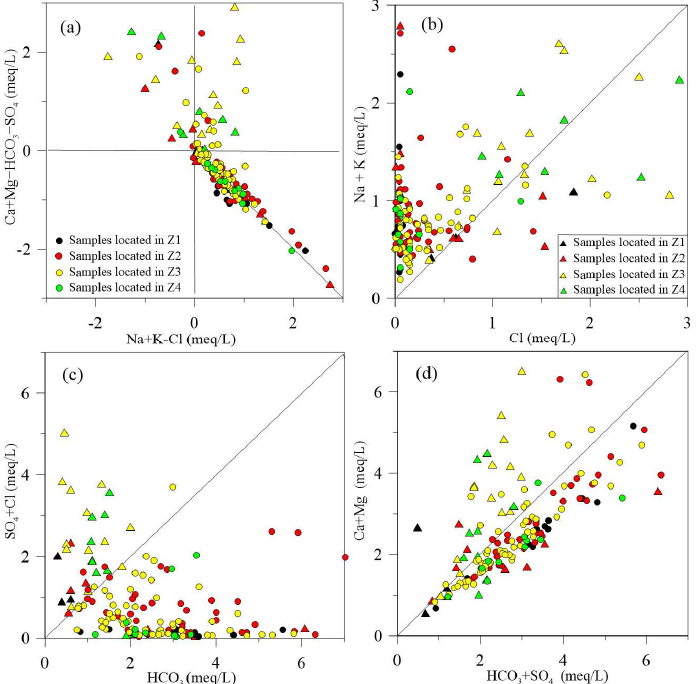
Figure 6. Bivariate diagrams of ( a ) (Ca+Mg-HCO 3 -SO 4 ) versus (Na+K-Cl), ( b ) (Na+K) versus Cl, ( c ) (SO 4 +Cl) versus HCO 3 , ( d ) (Ca+Mg) versus (HCO 3 +SO 4